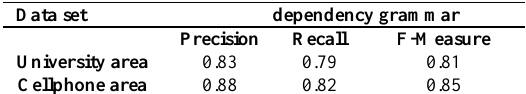
Table 6. Evaluation for extracted opinion words.